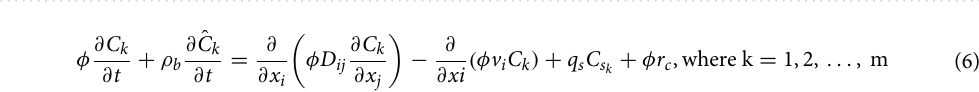
is the concentration of the k th species in the sources or sinks k C k is the solid-phase concentration of the k th species (M/M), (cid:31)